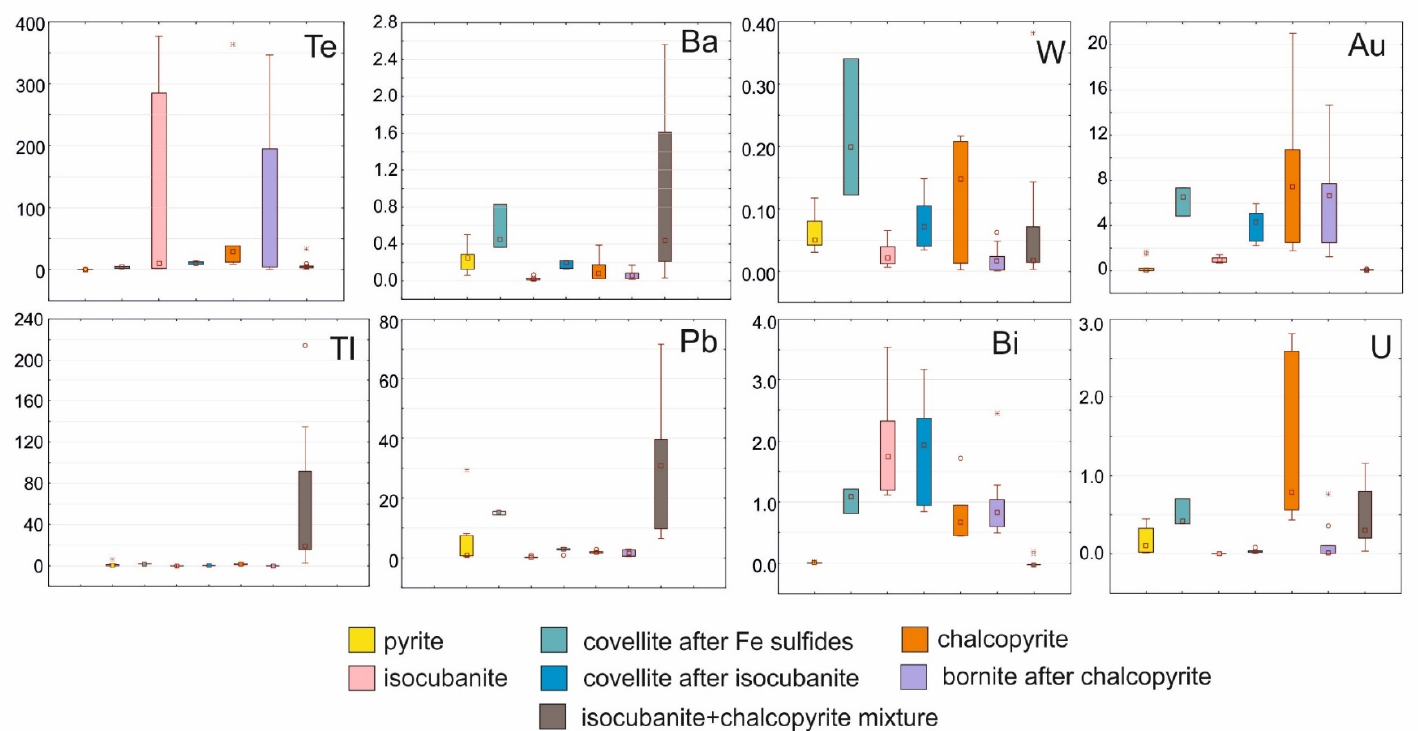
Figure 5. Box-and-whisker plots for selected trace elements (ppm) in sulfides of the Ashadze-2 hydrothermal field.